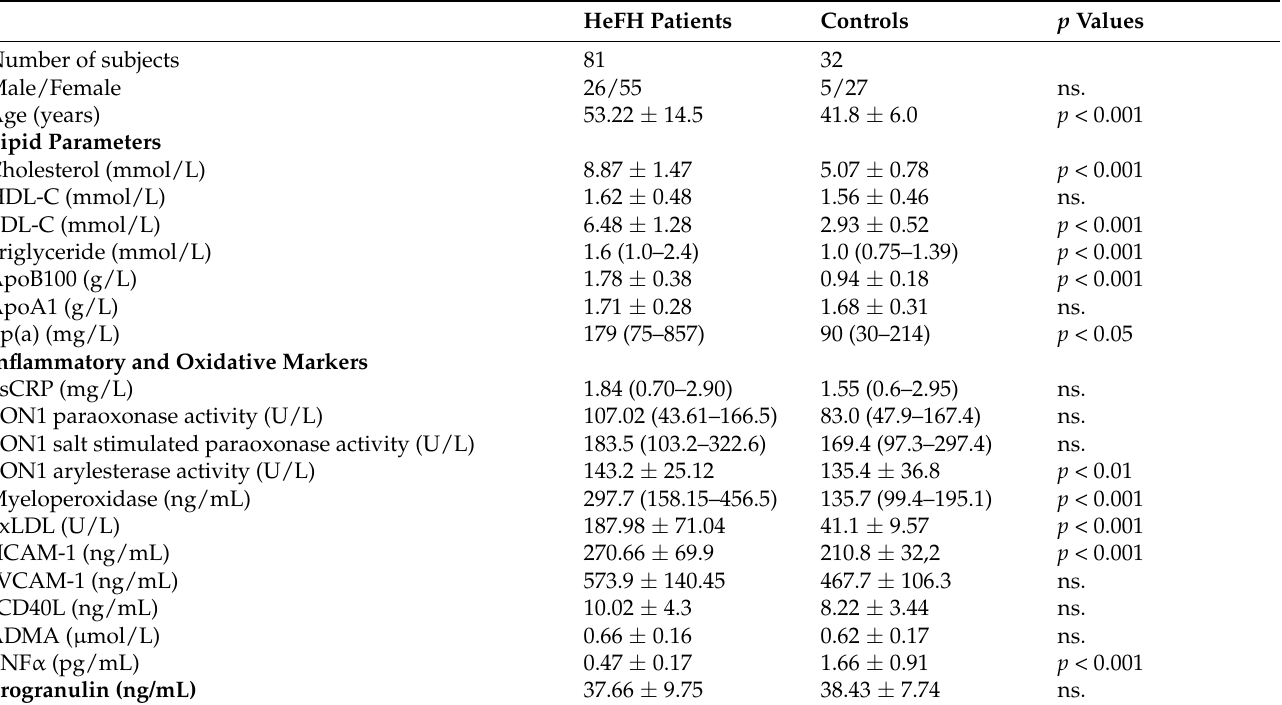
Table 1. The anthropometric and laboratory parameters of the study individuals. The values are presented as mean ± standard deviation or median (lower quartile–upper quartile).